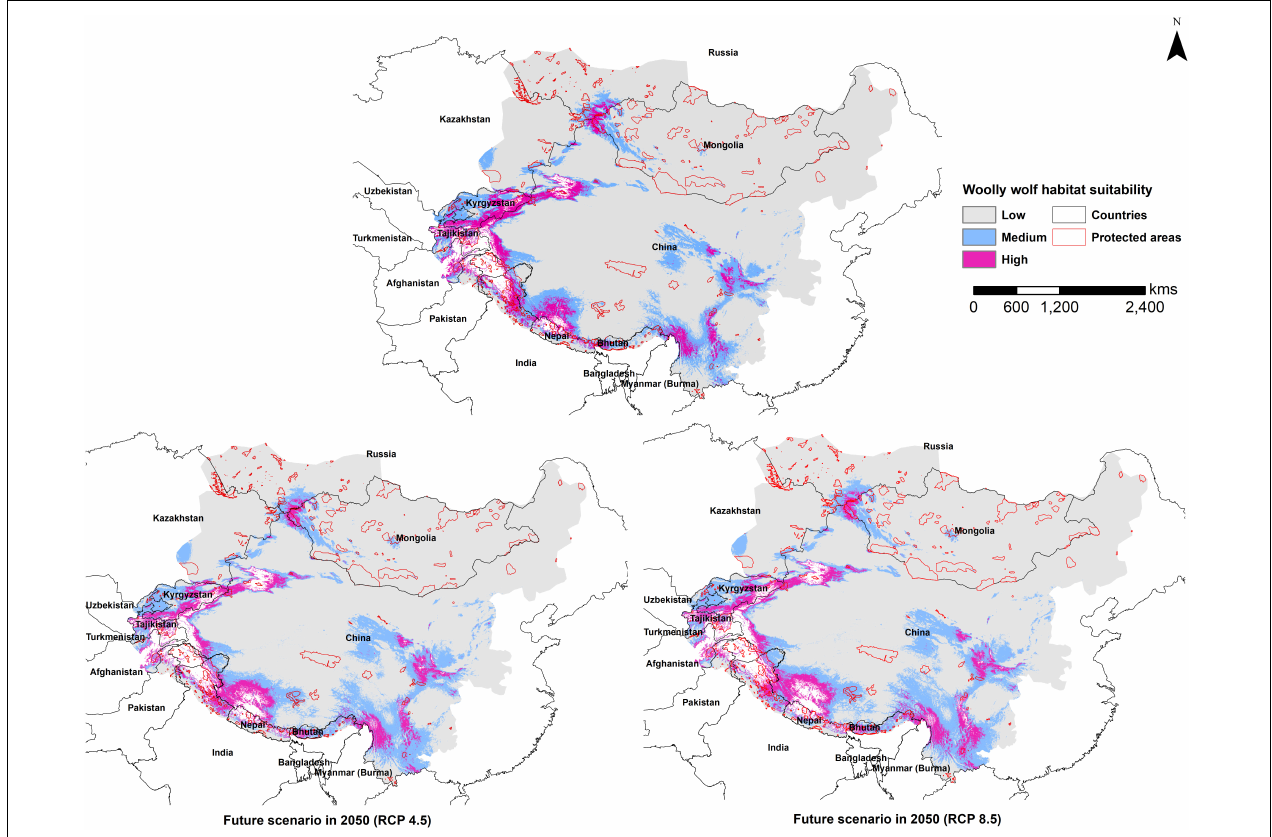
FIGURE 3 | Wooly wolf distribution model showing current and future trends of suitable habitat for the species for two future climate scenarios (RCP 4.5 and 8.5) for the year 2050 with the countries and protected areas boundary within the intensive study